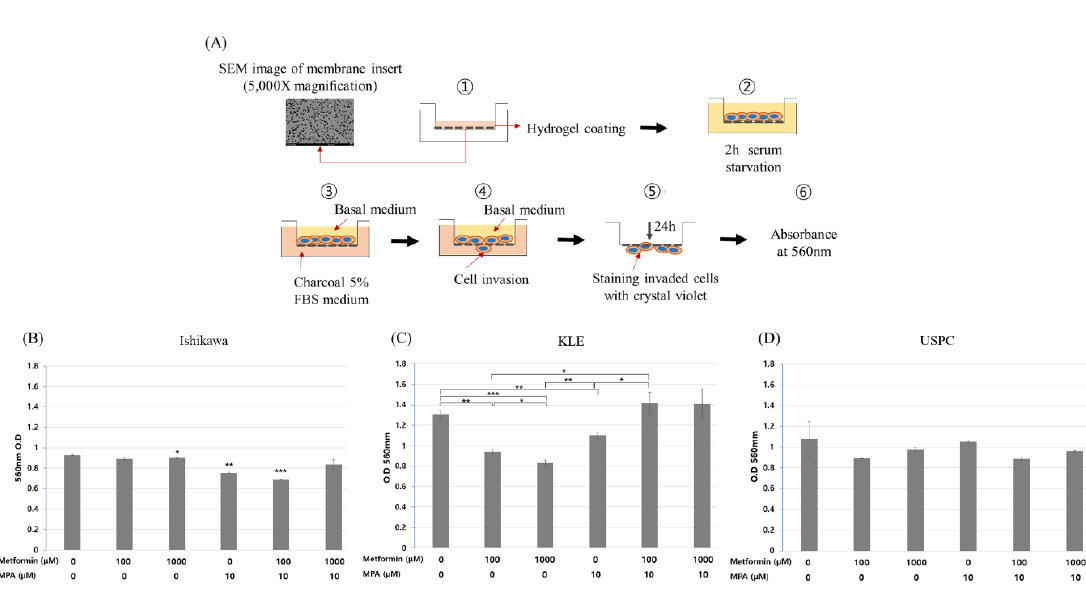
Figure 3. Invasion assay in three endometrial cancer cell lines (Ishikawa, KLE, and USPC). ( A ) The process of invasion assay, cell invasion after treatment of different dose combinations of medroxyprogesterone (MPA) (0, 10 µM) and metformin (0, 100, 1000 µM) in Ishikawa ( B ), KLE ( C ), and USPC cells ( D ). ( B ) All comparisons were with control (no metformin/MPA). ( B – D ) Each experiment was independently performed in triplicate: results are expressed as mean ± standard deviation. Multiple testing correction was performed using Bonferroni adjustment and Bonferroni corrected p-values were used for statistical significance ( B – D ). * p < 0.05, ** p < 0.005, *** p < 0.0005.